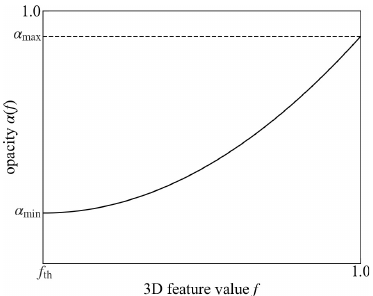
Figure 4. Typical relation between 3D feature value f and opacity α when adopting the function of type (b). α gradually increases for f larger than f th and forms a sharp peak at the maximal value of f . Figure 6. Typical relation between 3D feature value f and opacity α when adopting the function of type (c). α gradually increases in range f th ≤ f < F th and becomes constant for f larger than F th